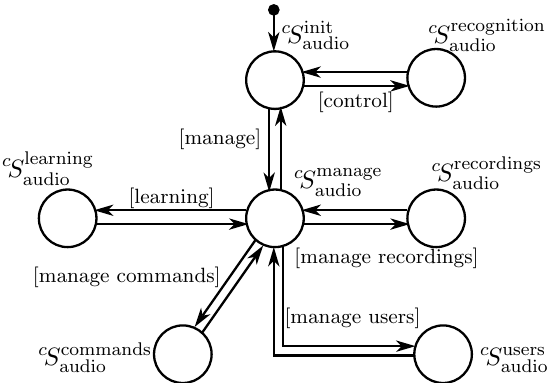
Figure 15. The FSM switching behaviours of the control subsystem c brackets enclose initial